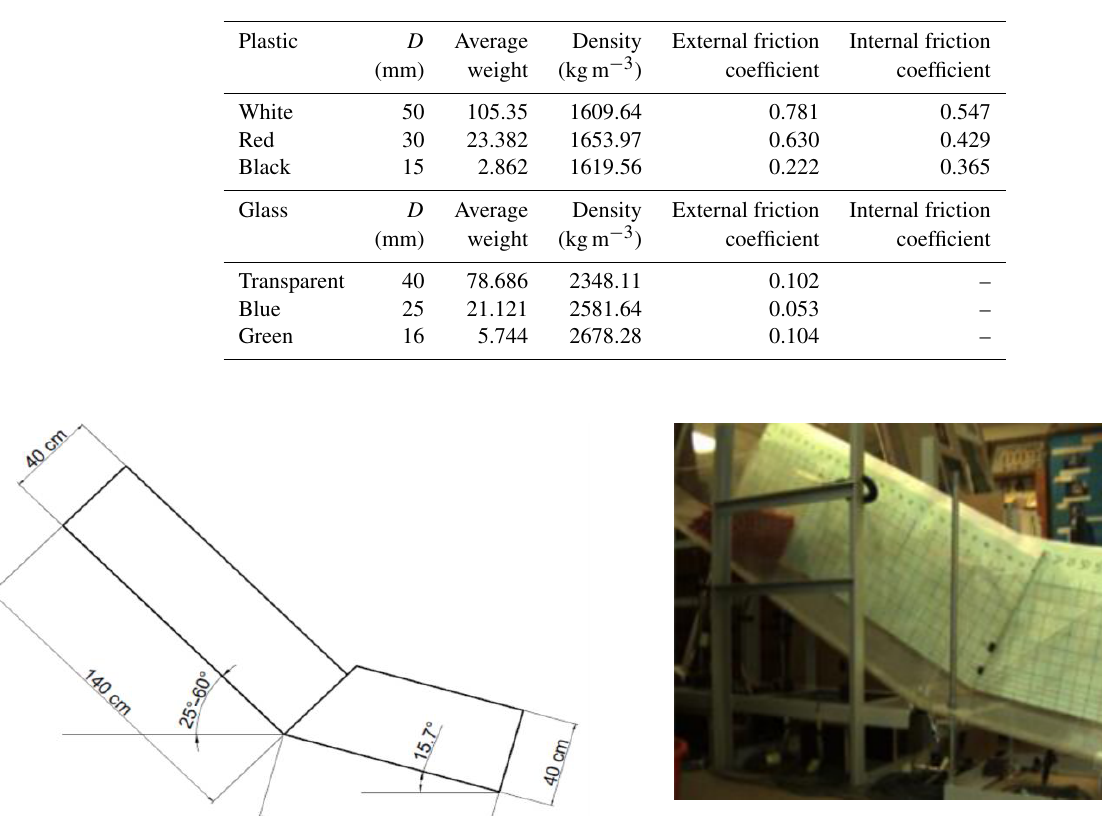
Table 1. The properties of the glass balls and plastic balls in the laboratory granular flow test.